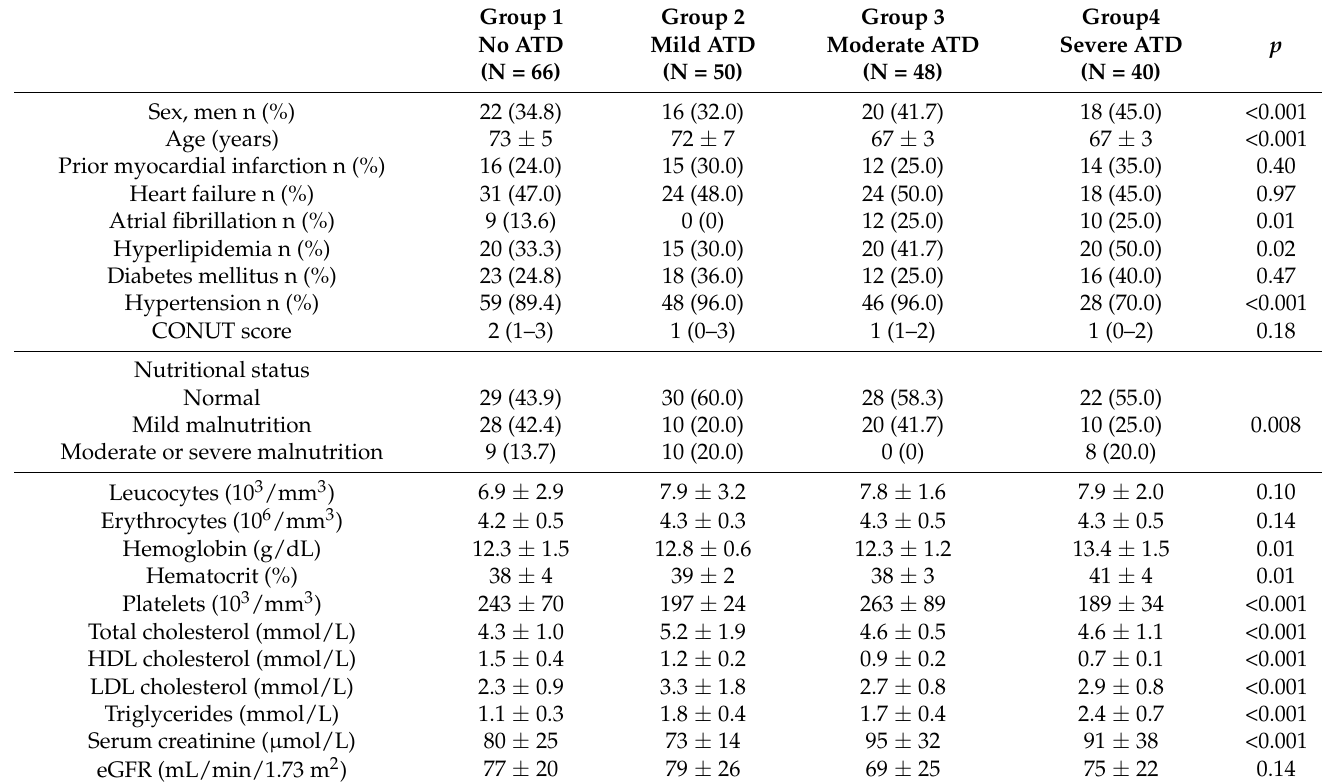
Table 3. Baseline clinical and laboratory characteristics.